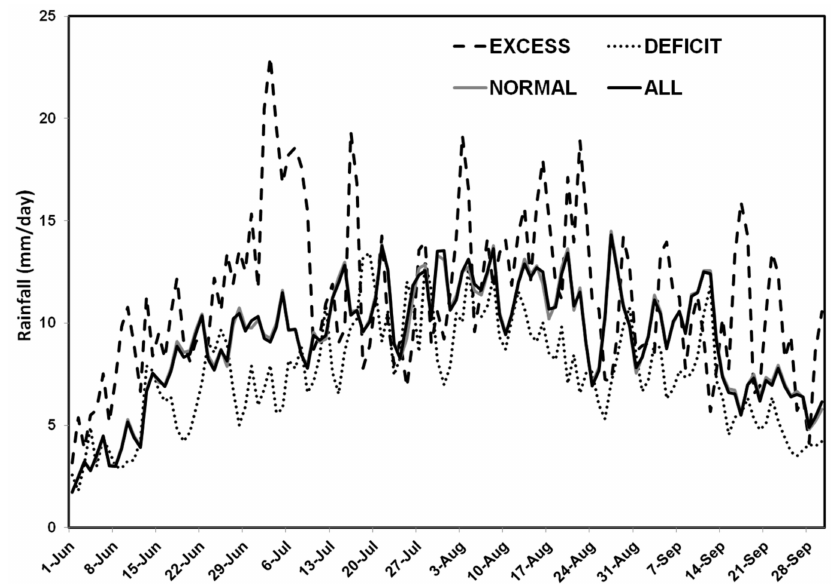
Figure 4. Seasonal cycle of the daily monsoon rainfall climatology composite over excess (dashed line), deficit (dotted line), normal (shaded line), and all 63 (thick line) years in the state of Odisha.